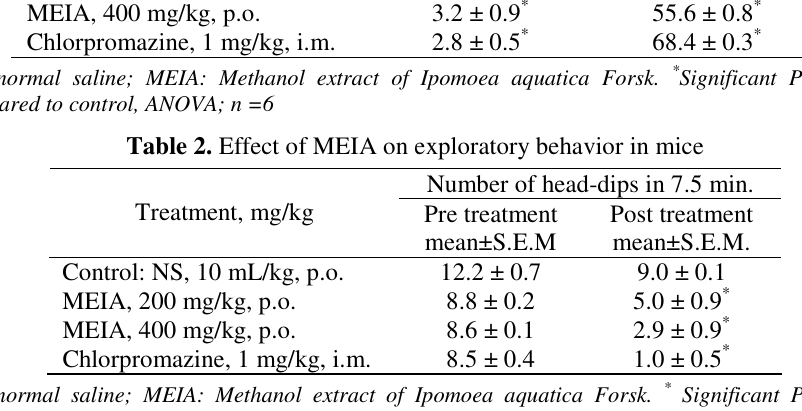
Table 1. Effect of MEIA on pentobarbitone induced sleeping time in mice Treatment, mg/kg